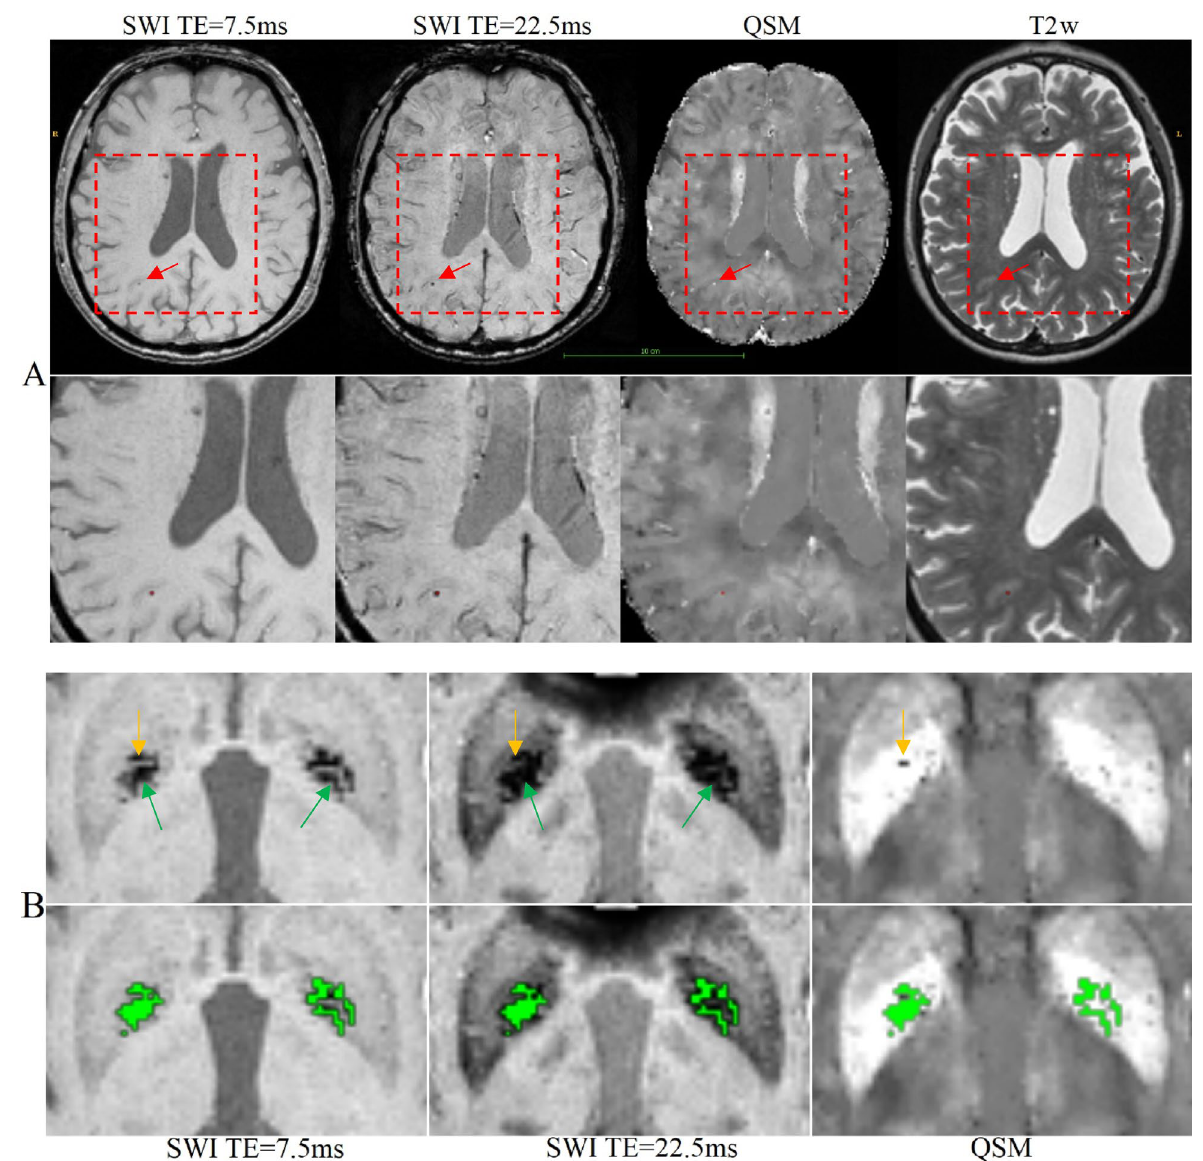
Figure 1. ( A ) Segmentations of CMBs by a model trained with SWI, QSM and T2w. (Top) An example of the correct segmentation of a small microbleed (red arrow). (Bottom) Magnified view of microbleed with segmentation mask (single red pixel). ( B ) An example of QSM being used to distinguish iron deposits from calcifications in the basal ganglia. (Top row) The SWI for TE = 7.5 ms, SWI for TE = 22.5 ms and QSM of the basal ganglia. The yellow arrow points to hypo-intense voxels which are likely calcifications and the green arrow points to basal ganglia iron deposits. (Bottom row) The segmentation mask (green labels) of the iron deposits. For both ( A , B ), the segmentations were generated by the multiclass model trained with SWI, QSM and result in terms of magnitude accuracy was seen when the model training includes QSM. This is also reflected by the correlation coefficients. Models which included QSM showed a higher correlation between the number of predicted lesions and reference annotation. For CMBs, the correlation r = 0.51 and r = 0.69, for single class and multiclass results, respectively. For iron deposits, the correlation r = 0.94 and r = 0.97 for single class and one layer. The results of this experiment are reported in Supplementary Table 4.2 in Sect. 4 of the “Supplementary materials”. For detecting CMBs, the model trained with SWI, QSM and T2w has the highest magnitude accuracy. For detecting iron deposits, the model trained with SWI and QSM showed the highest magnitude accuracy but having a lower correlation coefficient (r = 0.75), while the model trained with SWI, QSM and T2w reports similar magnitude accuracy and higher correlation coefficient (r = 0.93).